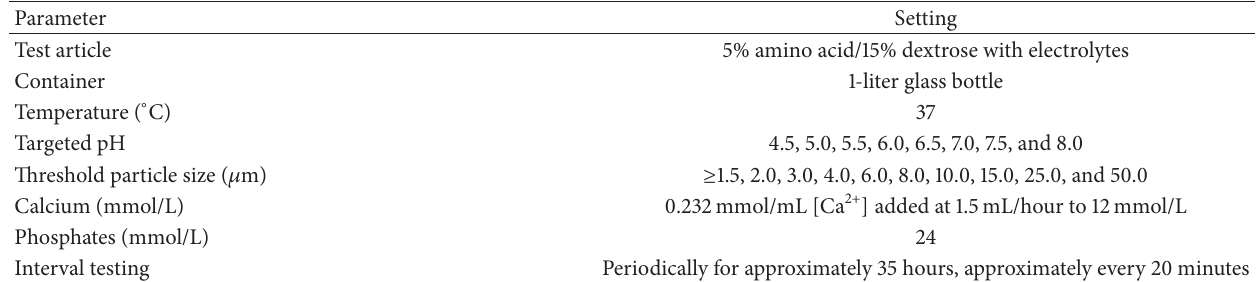
Table 3: Calcium phosphate solubility in an admixture—conditions for effect of